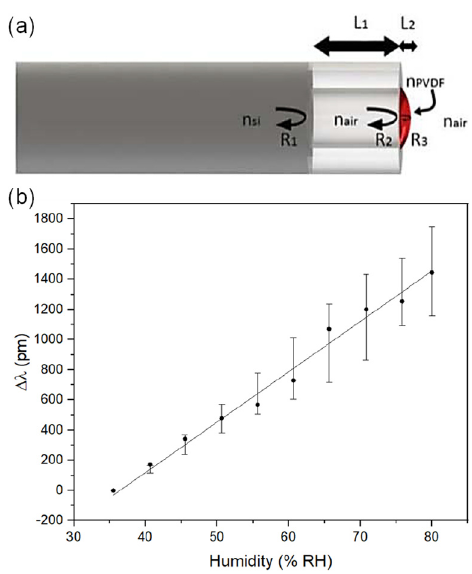
Figure 29. Point sensor. ( a ) Conceptual design of sensor head. ( b ) Wavelength shift with different RH. Adapted with permission from ref. [147]. Copyright 2019 IEEE